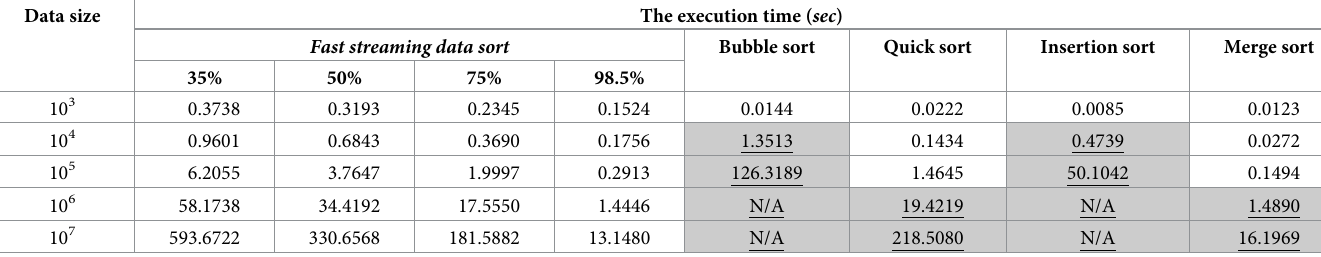
Table 4. Comparison of sorting time between fast streaming data sort and four classic sorting algorithms. Data size